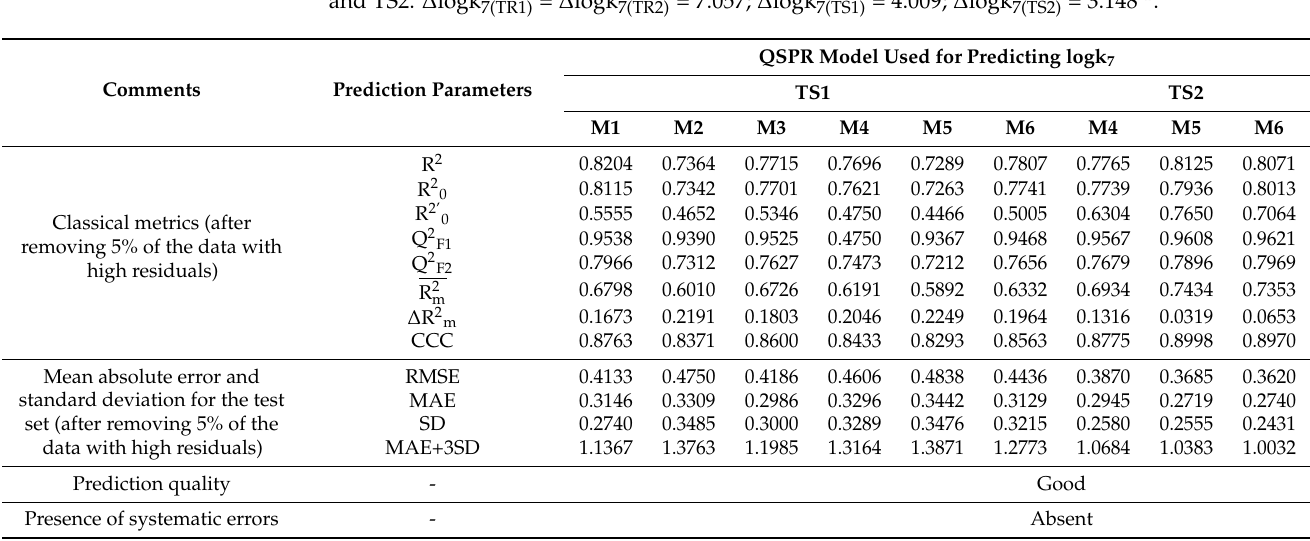
Table 3. Validation parameters of the QSPR models estimated using the Xternal Validation Plus 1.2 program based on the experimental and predicted logk 7 values of the compounds of test sets